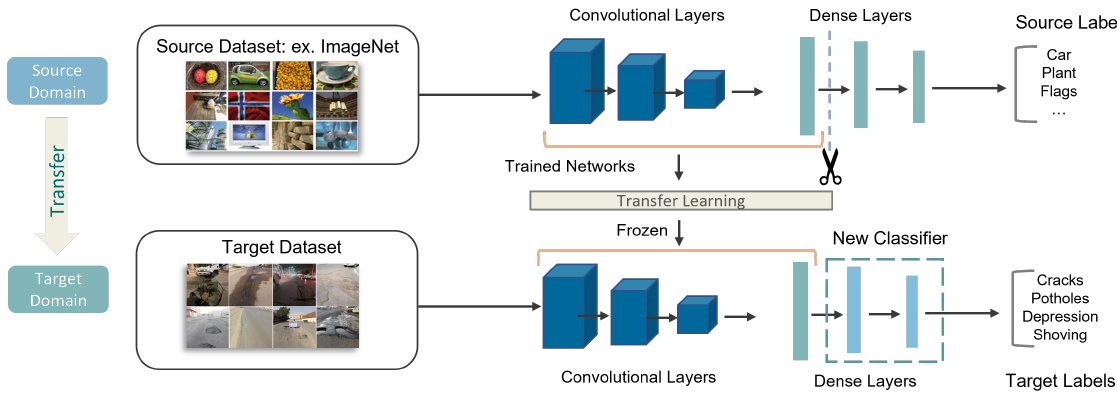
Figure 5. Schematic representation of our transfer learning models.